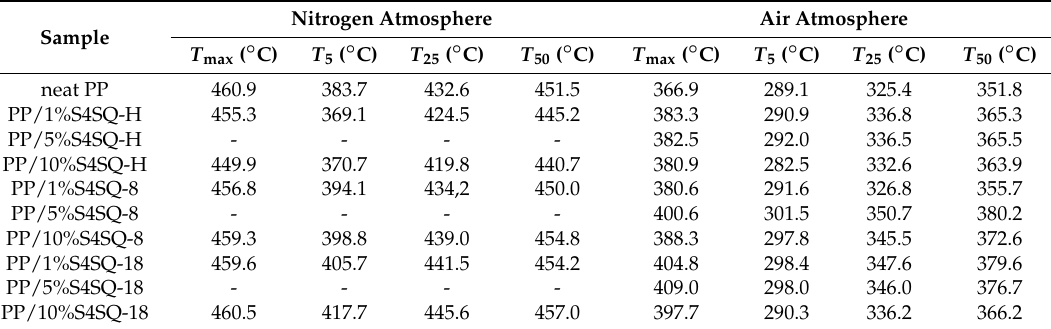
Table 1. TG data of neat polypropylene (PP) and PP/S4SQ composites.